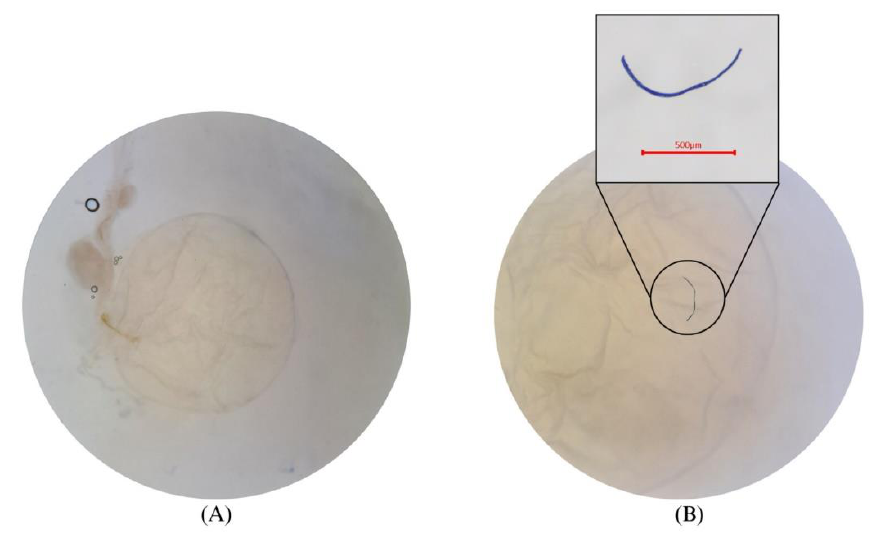
Figure 7 . The presence of microfiber contamination in fish eggs : ( A ) microfiber - free pierced eggs, and ( B ) microfiber - contaminated fish eggs .